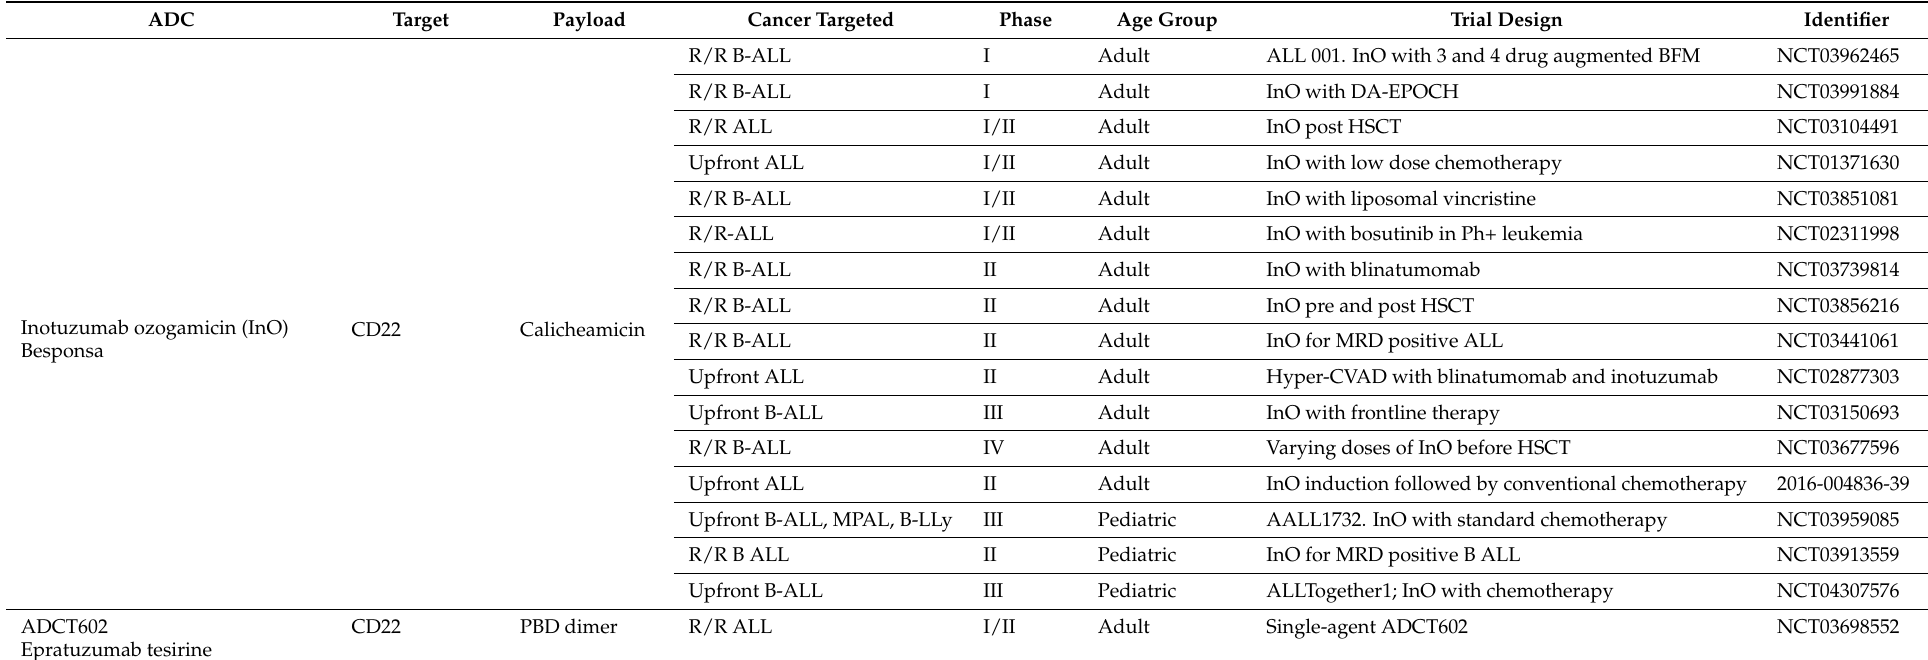
Table 1. Active clinical trials utilizing ADCs for acute